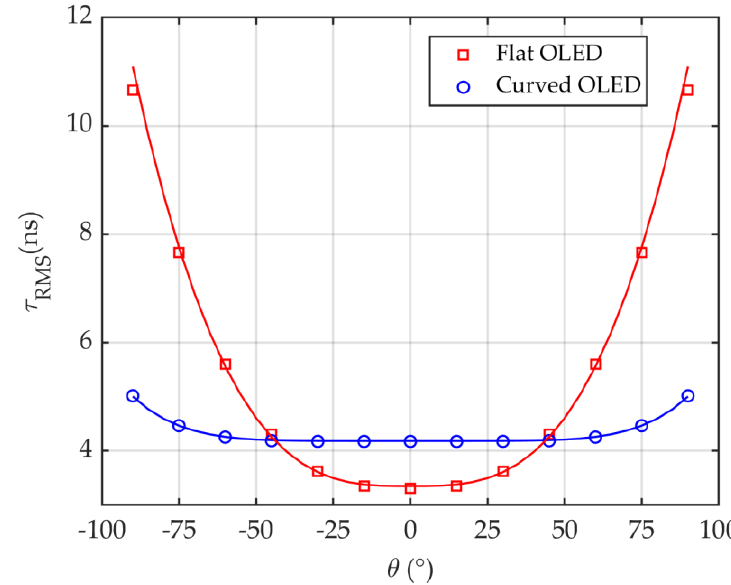
Figure 7. Comparison of a flat and curved OLEDs employed in the o ffi ce in term of τ RMS . Table 2. Numerical modeling parameters for 𝜏 RMS in the case of using flat and curved OLEDs in office.